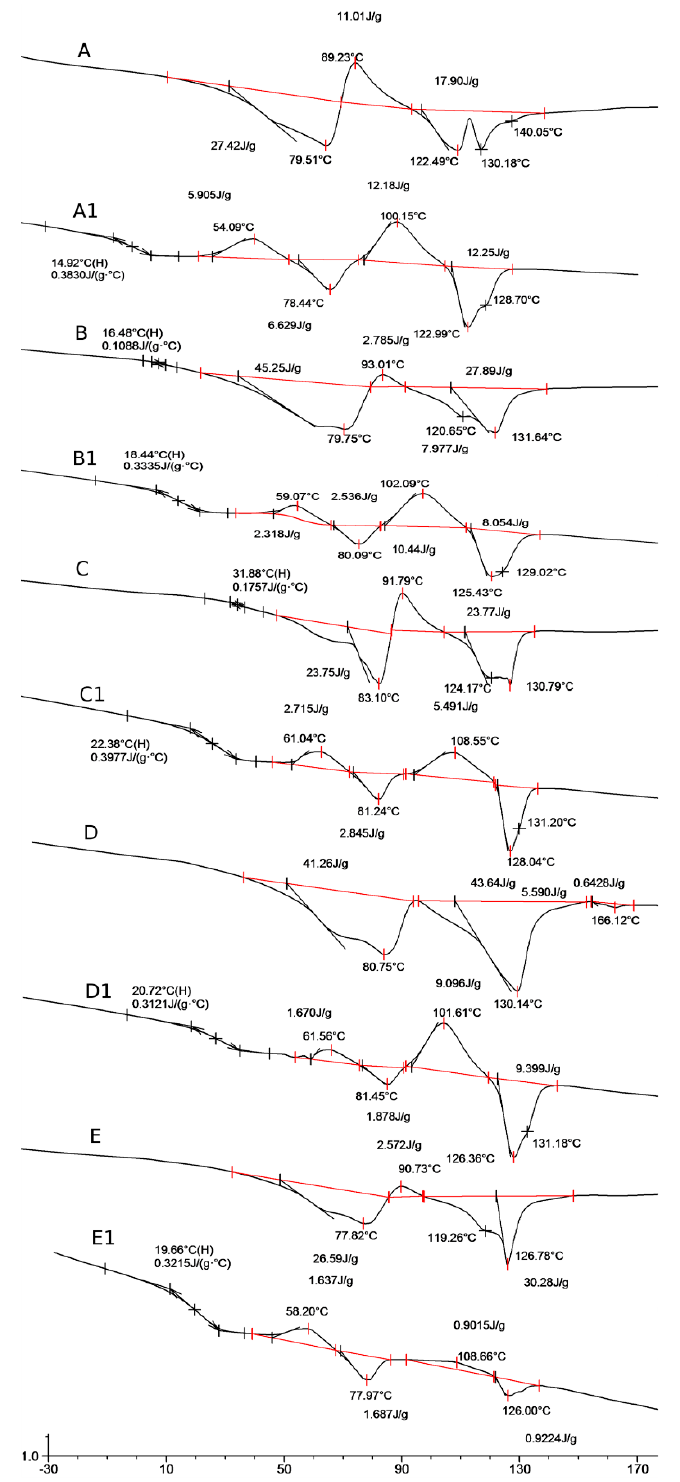
Figure 3. DSC thermograms of the PLGA-block-PEG / dextrin-g-CL blends, ( A ) 1D run I, ( A1 ) 1D runII; ( B ) 2D run I, ( B1 ) 2D run II; ( C ) 10D run I, ( C1 ) 10D run II; ( D )11D run1, ( D1 ) 11D run II; ( E ) OD2 run I, ( E1 ) OD2 run II.